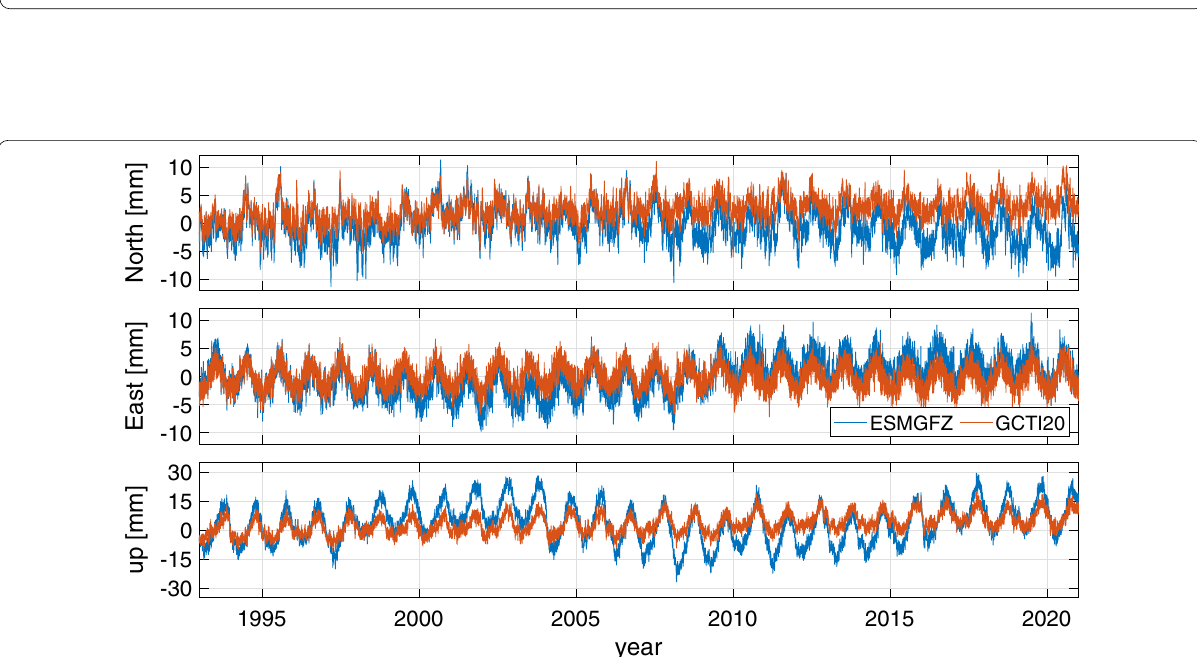
Fig. 4 RMS values of the differences between the site displacements of GCTI20 and ESMGFZ for the combined loading (NTAL [ SLEL]) at GNSS stations. Left column: CM-frame, right column: CF-frame. Top: North, middle: East, bottom: up (different scale compared to the + horizontal components)